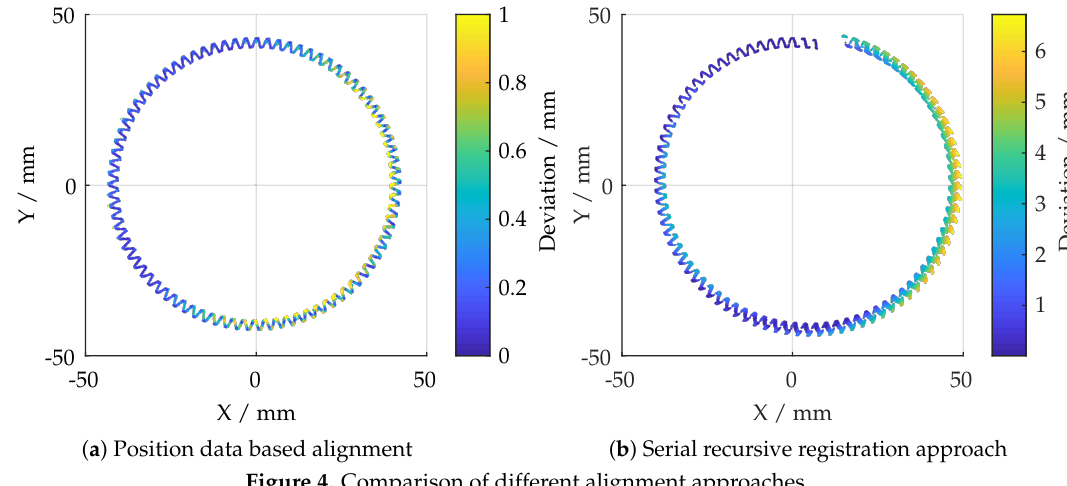
Figure 4. Comparison of different alignment approaches.